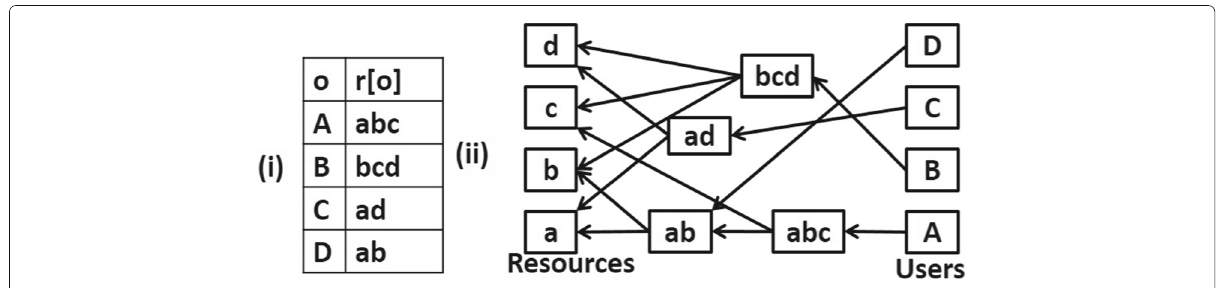
Fig. 4 ( i ) An example CPLs, and ( ii ) A resource hierarchy